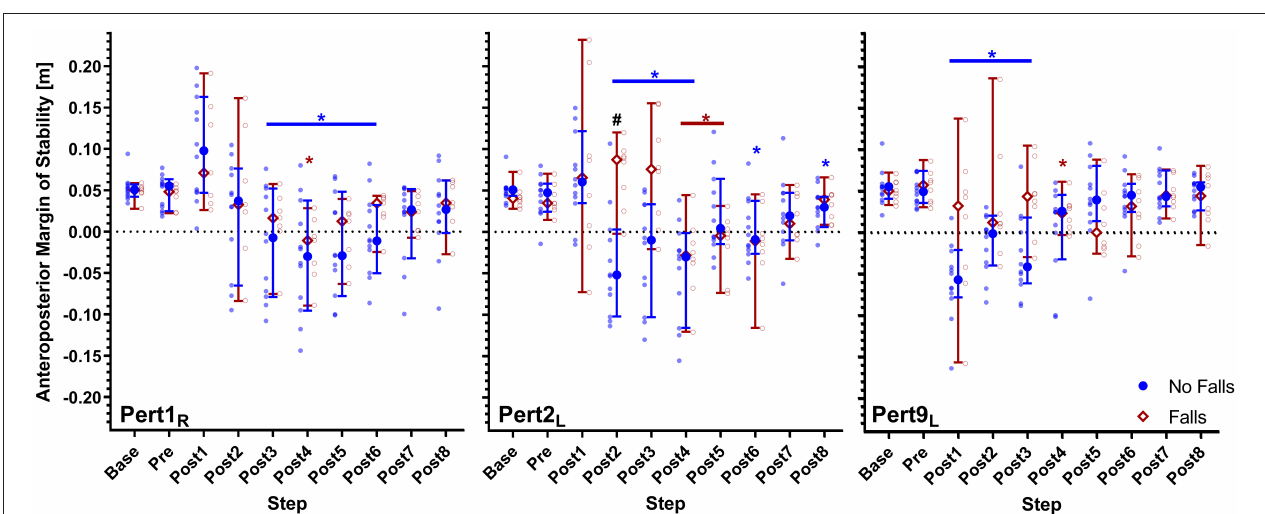
FIGURE 2 | Median and 95% confidence intervals (with individual data points) of the anteroposterior margins of stability during the first, second and ninth perturbations (Pert1 R , Pert2 L , and Pert9 L , respectively) including unperturbed walking prior to each perturbation (Base), the final step prior to each perturbation (Pre) and the first eight recovery steps following the perturbations (Post1–8) for Falls and No-Falls groups. Blue * and Red *: significant difference to Base for the No Falls and Falls groups, respectively ( P < 0.05; adjusted using Dunnett’s multiple comparisons test). # Significant difference between the No Falls and Falls groups ( P < 0.05; adjusted using Sidak’s multiple comparisons test).